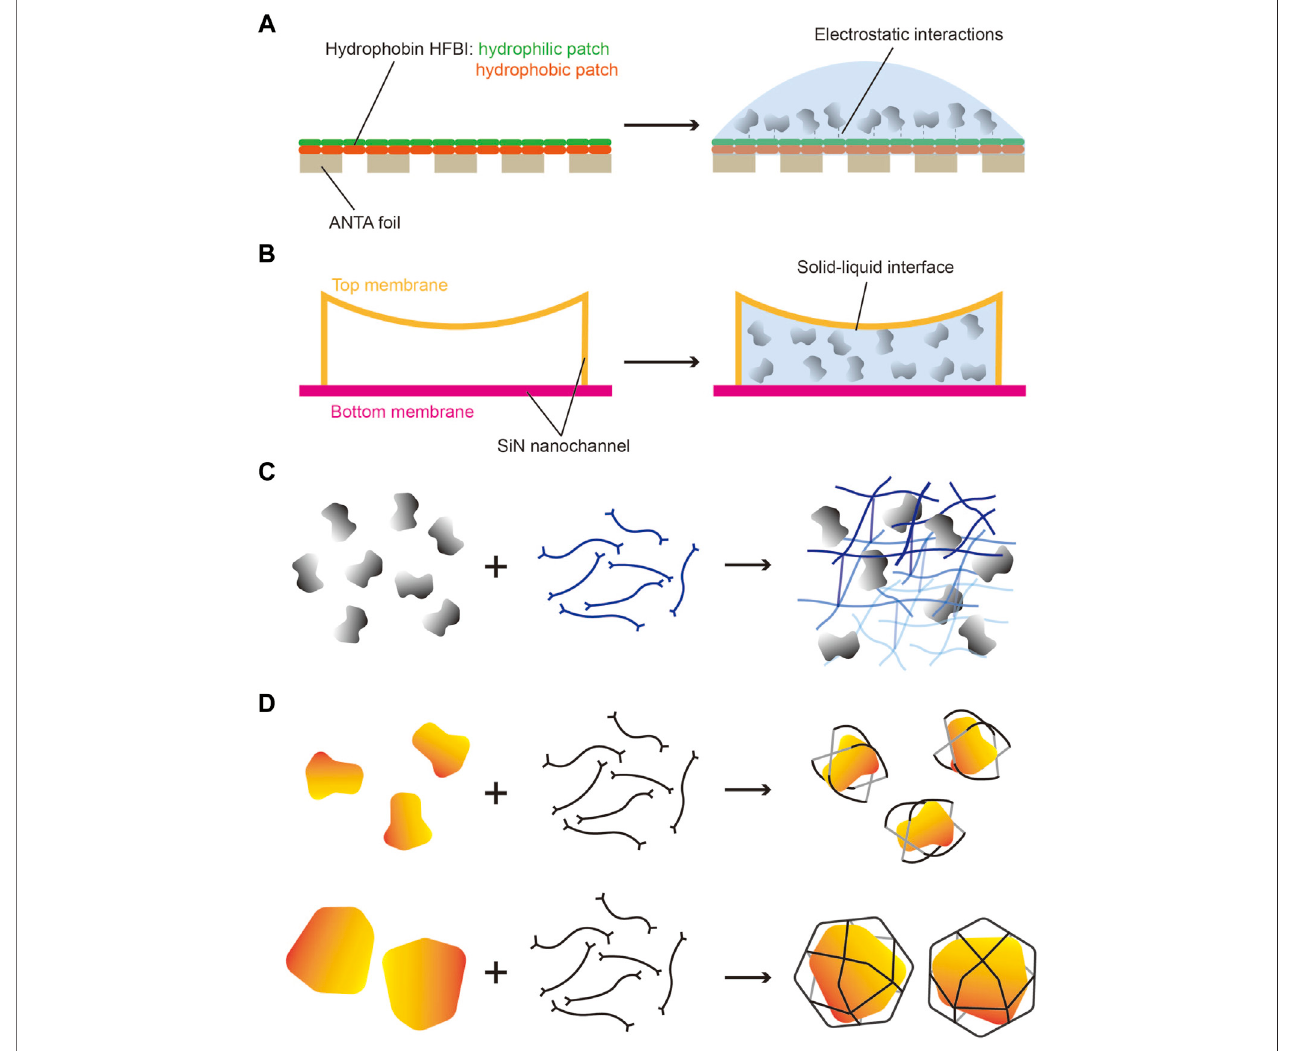
FIGURE 2 | Potential strategies for addressing problems in cryo-sample preparation. (A) HFBI grid has a continuous hydrophobin HFBI 2D crystals fi lm on the ANTA foil. The hydrophilic patches ofHFBI load sample and adsorb particles byelectrostatic interactions to keep particles away from the AWI. (B) Nano fl uidic cryo-chip has many electron-transparent nanochannels made of SiN X membrane. The sample solution is applied in closed nanochannels by capillary action without the AWI in vitri fi cation. (C) 3D chemical network can be designed to fi x particles in different orientations and uniform distribution. (D) Some chemical cages can be used to carry protein particles of different sizes to protect particles away from the AWI and provide random